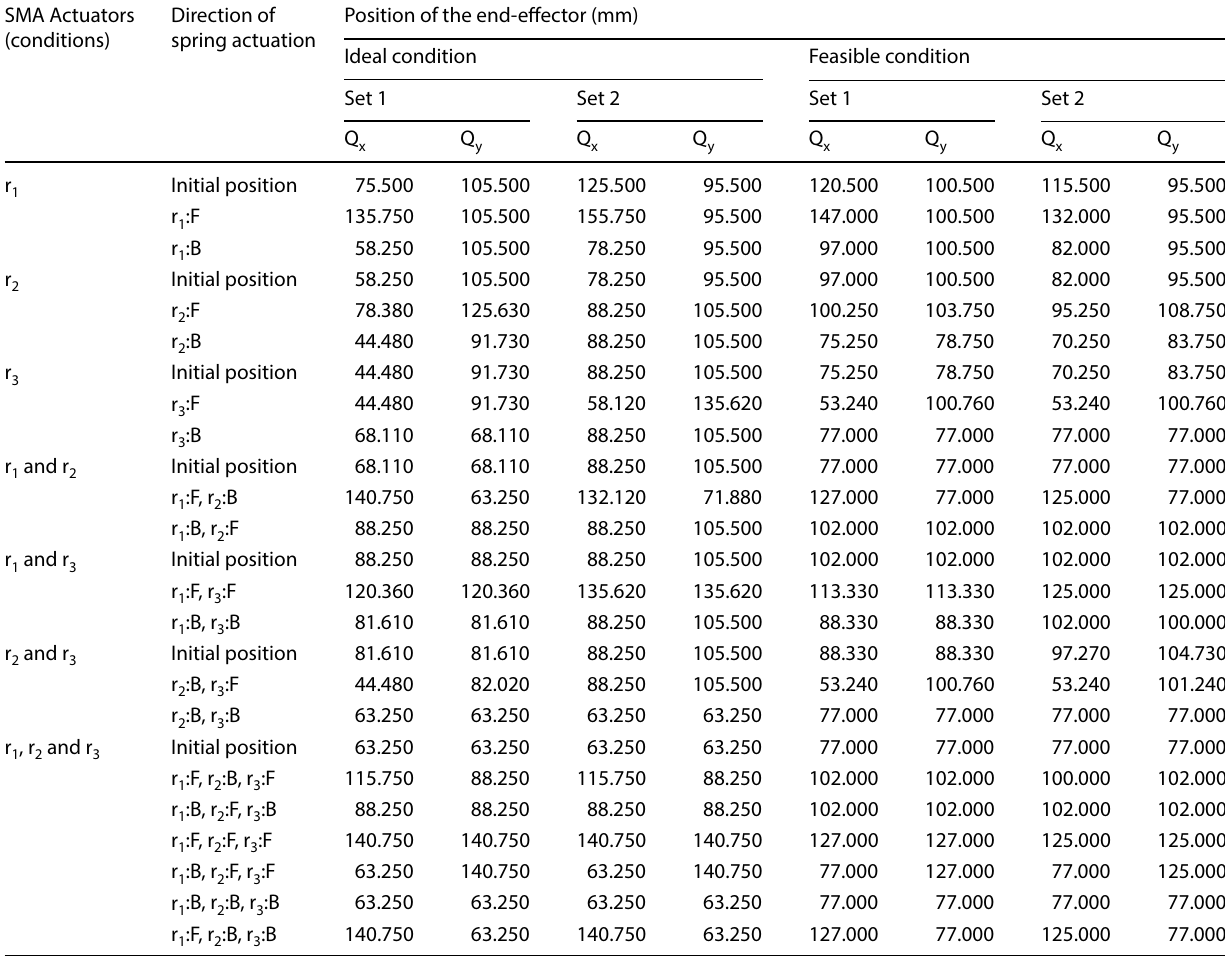
Table 6 End-effector position of C1 manipulator under ideal and feasible conditions